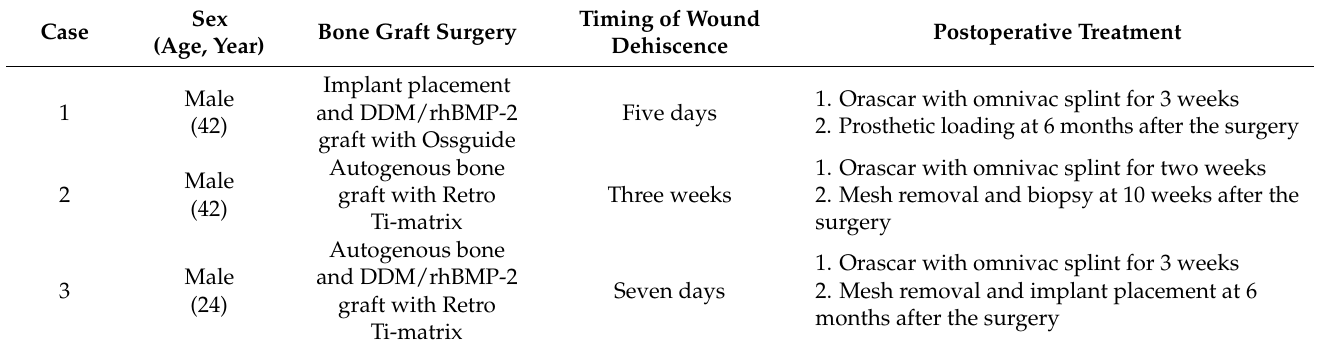
Table 1. Summary of the wound dehiscence cases with conservative